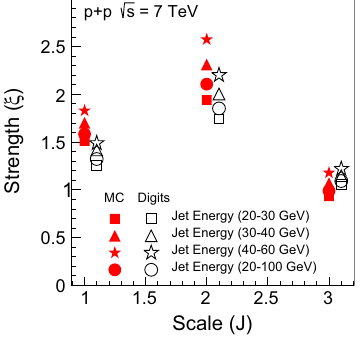
Fig. 7 Strength ( ξ ) vs. scale parameter with different jet percentage